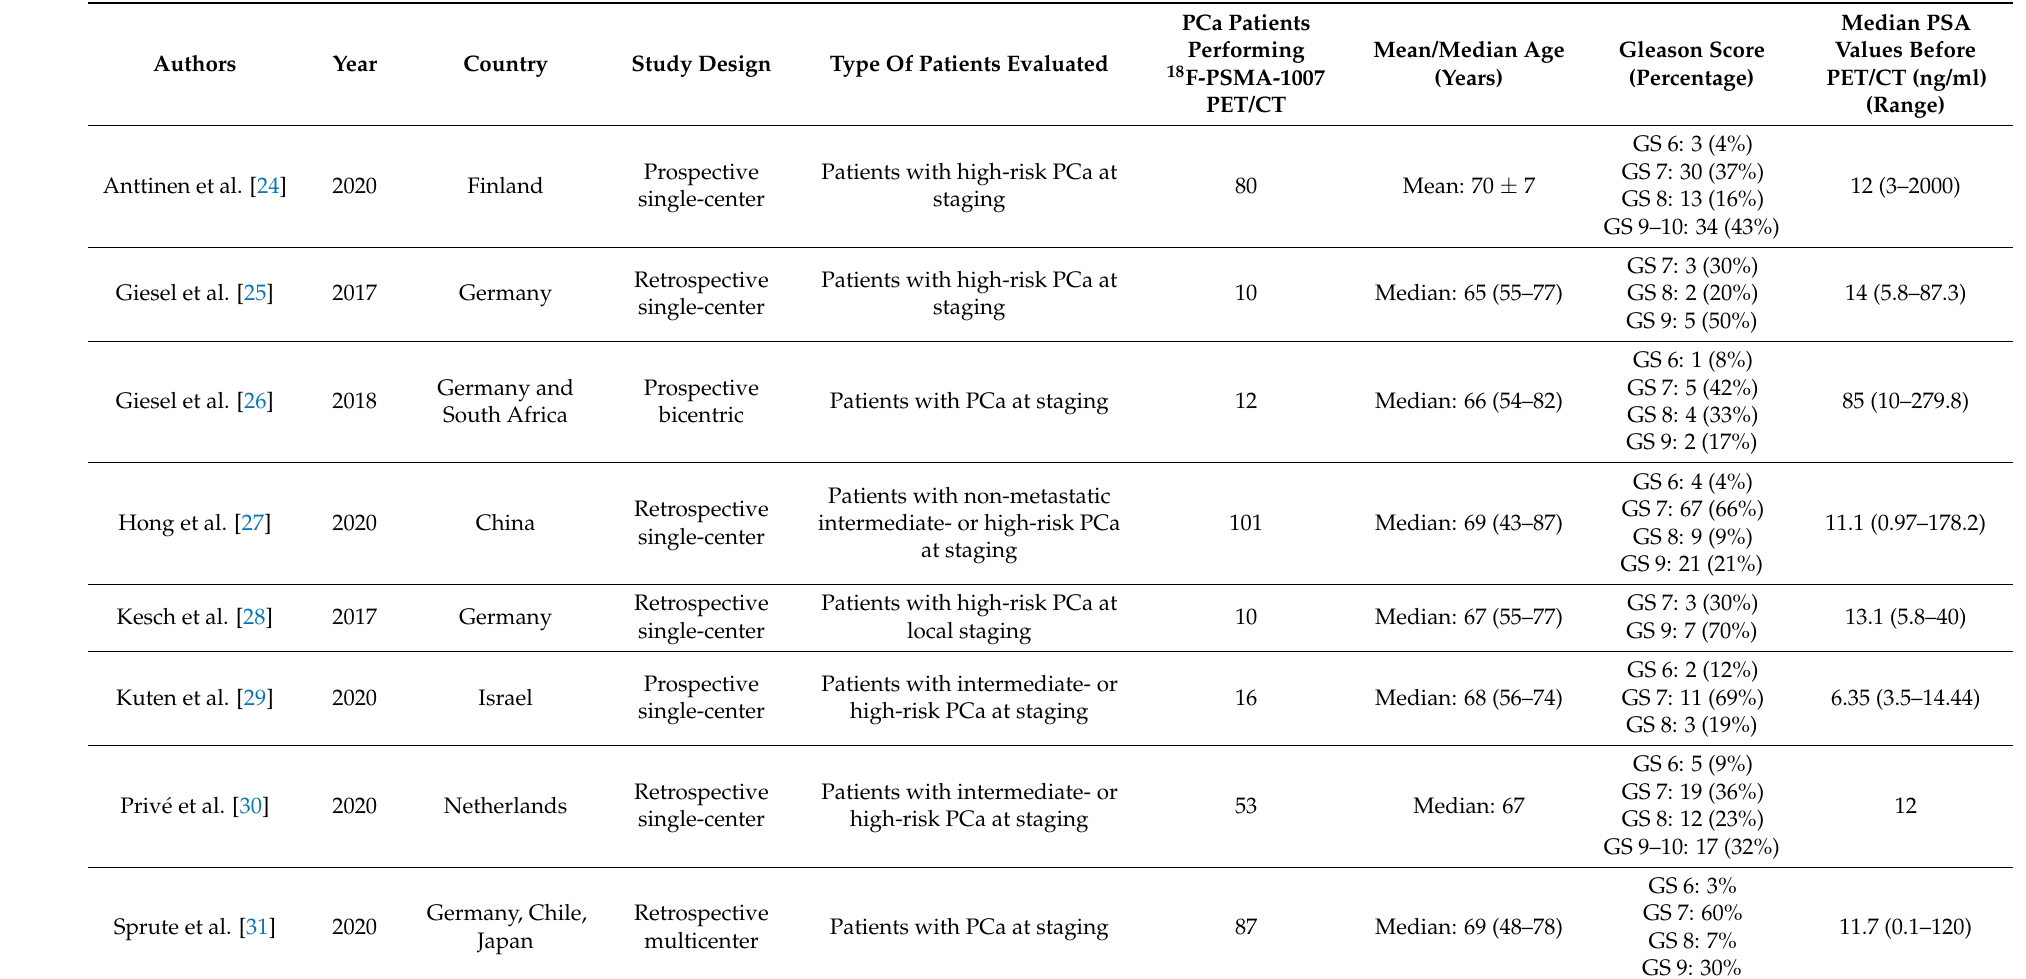
Table 1. Basic study and patient